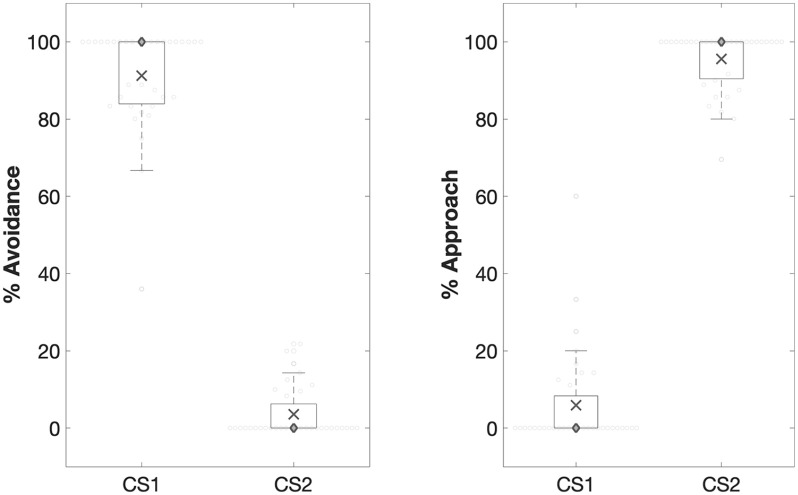
Avoidance learning. CS1 triggered more avoidance than CS2 during avoidance learning. CS2 triggered more approach than CS1. ○ = Individual data points; X = mean; ◊ = median. Edges of the box are the 25th and 75th percentiles. Whiskers extend to extreme value not considered to be an outlier: 2.7th and 99.3th percentile (based on MATLAB’s boxplot function). ***p < .0001.